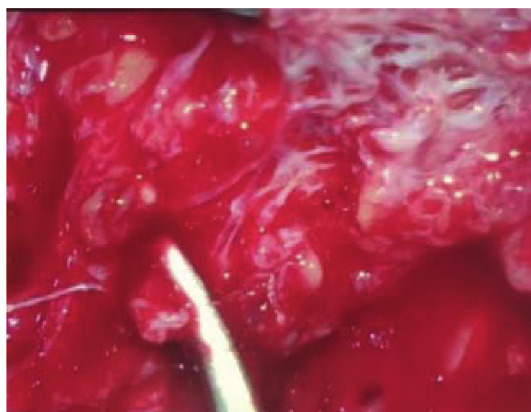
Figure 4: Intraoperative picture of dilated, irregular vascular channels replacing the superficial parotid parenchyma.